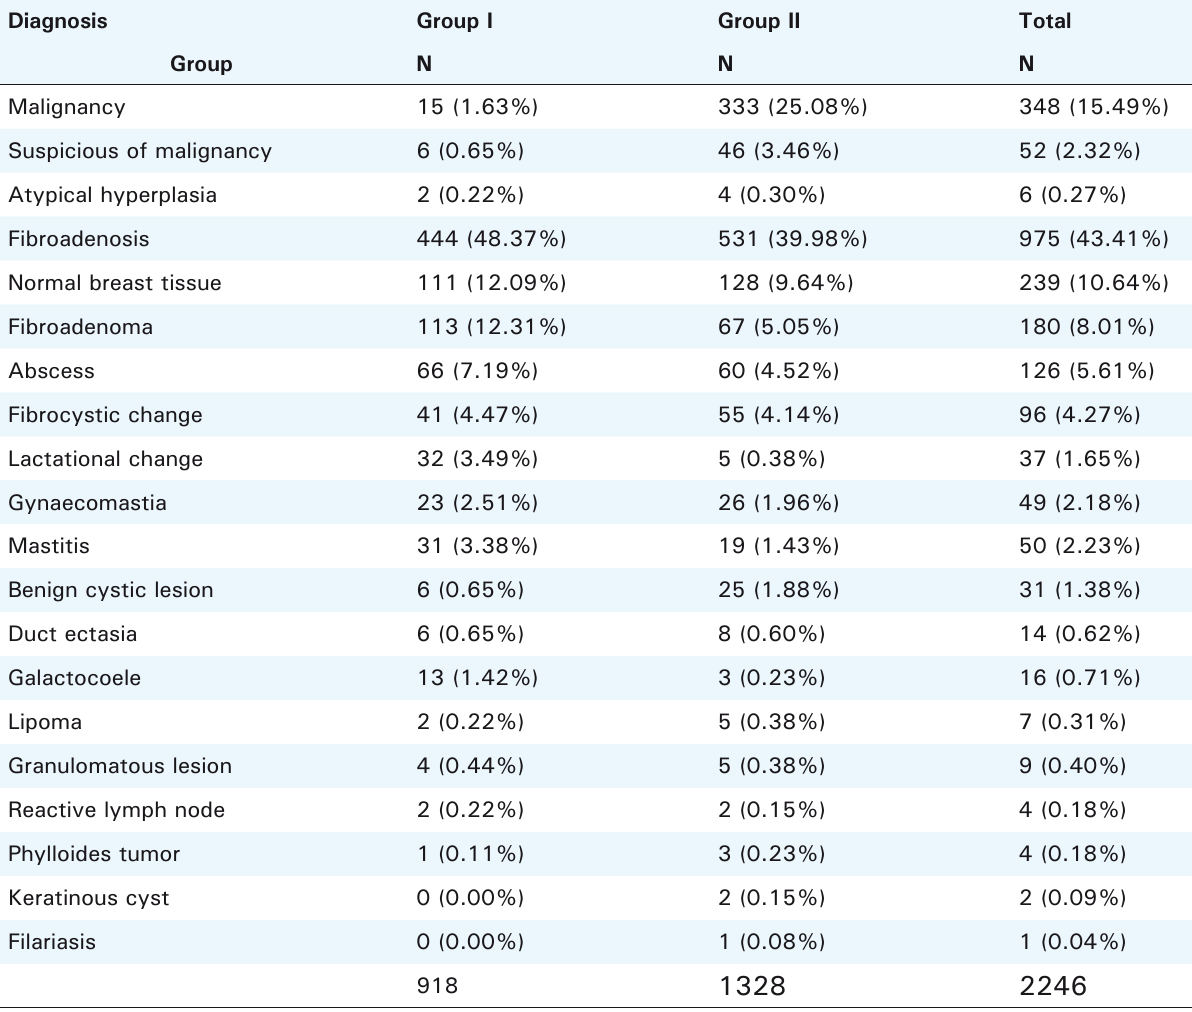
table 1. Fine-needle (FNA) diagnoses of group I (patients aged 30 years or younger) and group II (patients aged